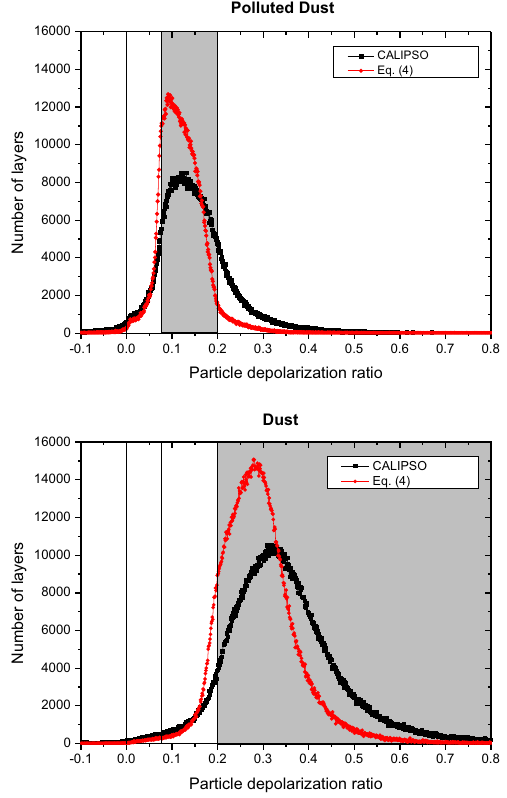
Fig. 4. Upper: particle depolarization ratio distributions for the pol- luted dust layers examined. Black curve represents the reported Level 2 product by CALIPSO and red curve represents the recal- culated values using perpendicular and total backscatter product. Lower: the same as upper panel but for layers categorized as dust. Grey areas denote the classification thresholds for polluted dust and dust that are followed by CALIPSO algorithm using the Level 1 approximated depolarization